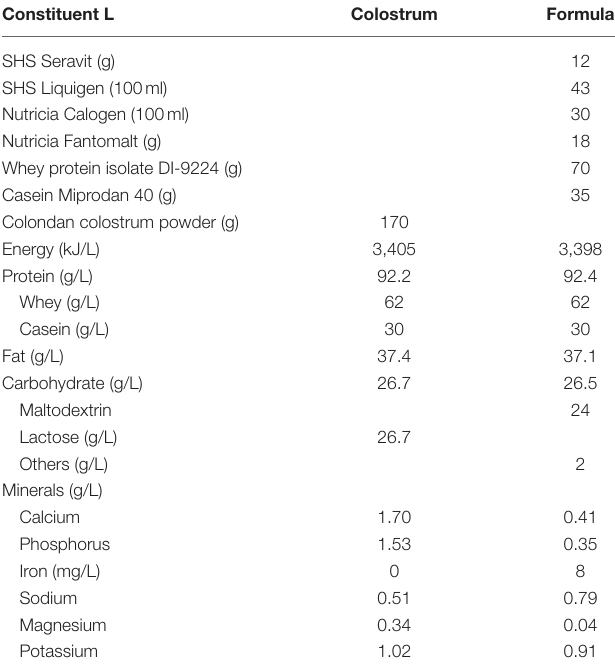
TABLE 1 | Nutrient composition of experimental